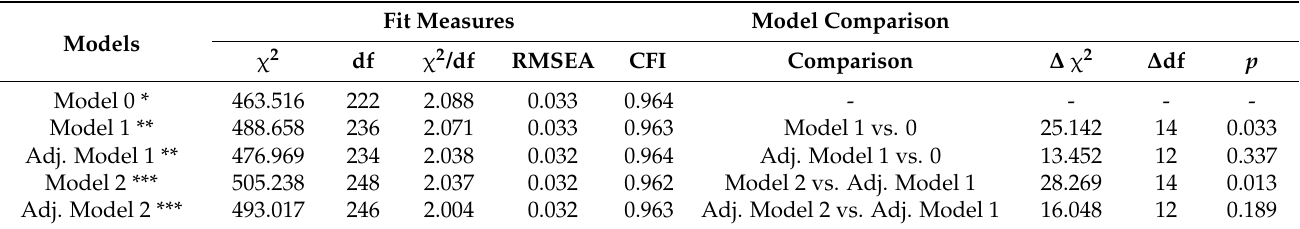
Table 8. Measurement invariance of MES across gender.